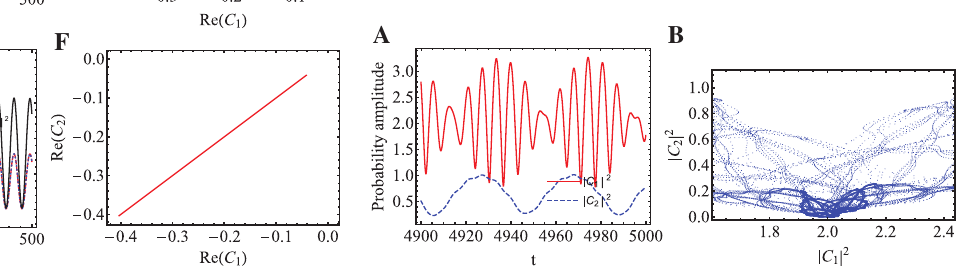
Figure 2: The time evolution of the probability of two-mode photons and the phase diagram.